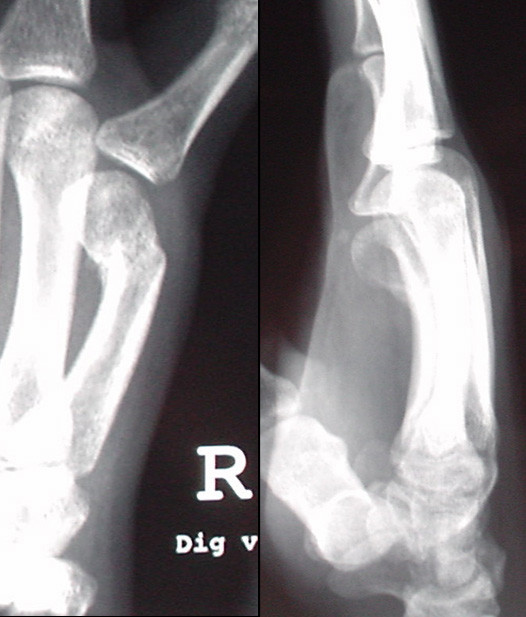
Malunion of the fifth metacarpal bone of the right hand.